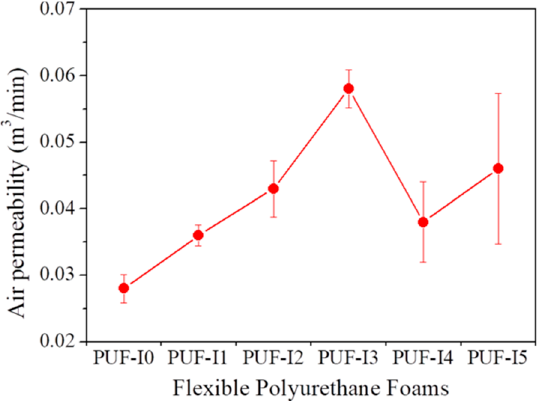
Figure 9. Air permeability of the FPUFs with various ISB content after thermal treatment at 160 °C.